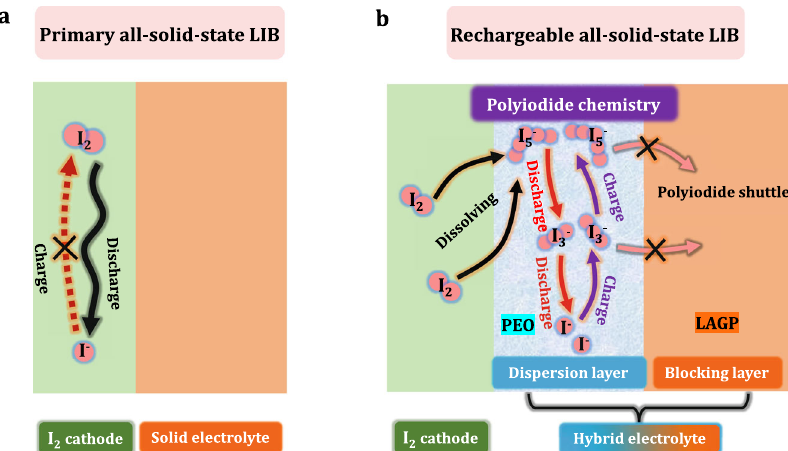
Fig. 1 Schematic of the reaction mechanism at cathode/electrolyte interface in (a) the primary all-solid-state LIB and (b) a rechargeable all-solid-state LIB in this work. In the primary all-solid-state LIB, the solid-phase conversion process between I 2 and I − suffers from a sluggish kinetics and leads to a poor rechargeability for the battery. In our proposed rechargeable all-solid-state LIB, a two-step polyiodide chemistry with fast kinetics and high reversibility is realized by the con fi ned dissolution strategy. The polyiodides could be well dissolved in the dispersion layer, but their shuttling is avoided by the blocking layer. During the discharge process the I 5 − is fi rst discharged to I 3 − and then to I − . The charge process follows a conversion reaction from I − to I 3 − and − . Note that I − and is then dissolved in the dispersion layer. fi nally I 5 2 accepts electron from KB to form I 5